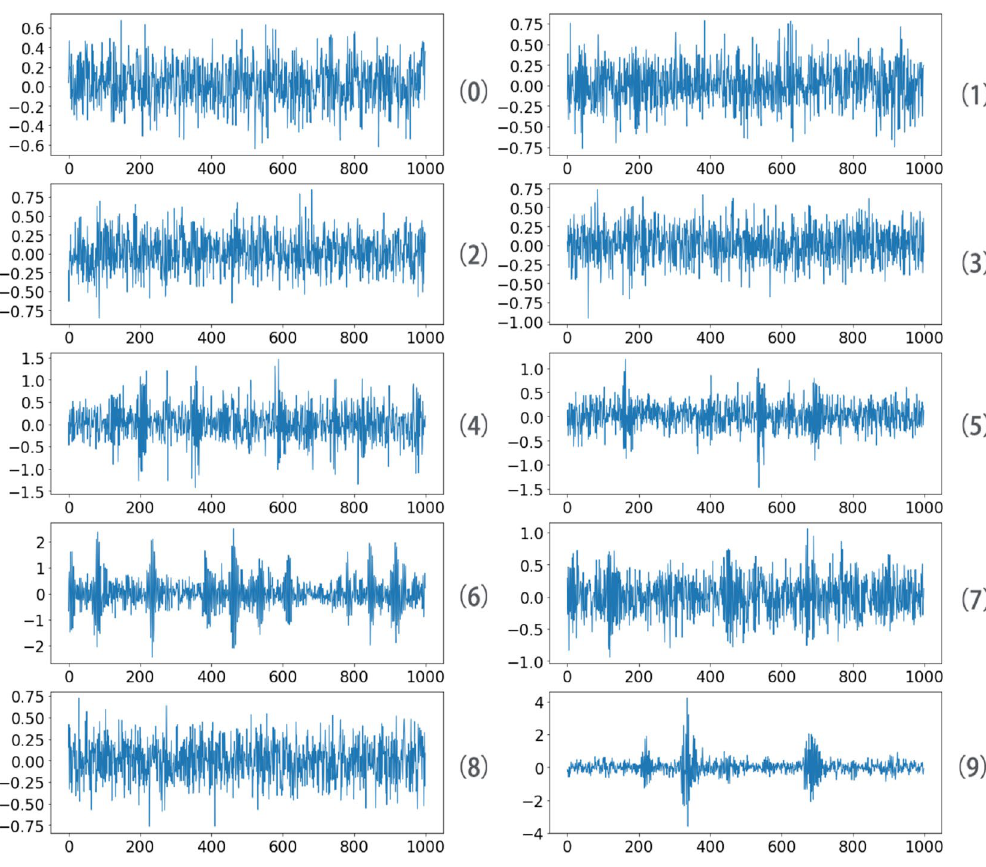
Figure 9. Fault bearing vibration data